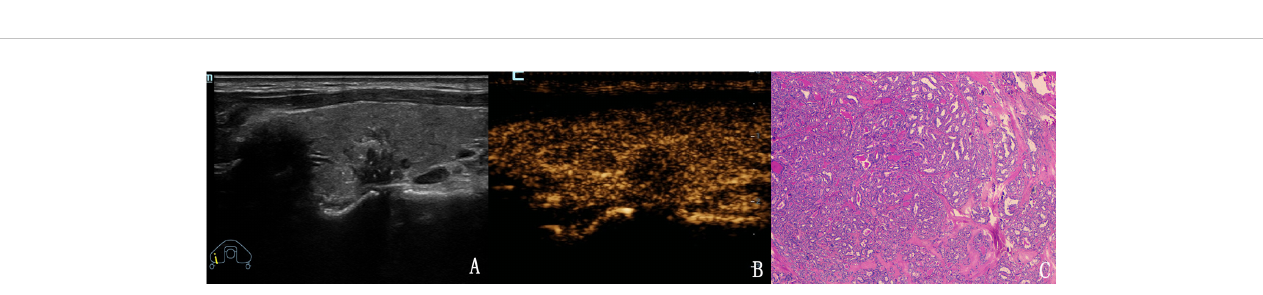
FIGURE 5 The case of a 43-year-old woman with a 15.2 × 11.1 × 12.5 mm solid hypo-echoic nodule in the right lobe of the thyroid. (A) Conventional two- dimensional image showing that the nodule had three malignant indicators (solid, irregular margin and microcalci fi cations) and was classi fi ed with a TI- RADS score of 4b. (B) Ultrasound contrast image showing low enhancement. The modi fi ed version of TI-RADS combined with CEUS returned a score of 5, and the patient was diagnosed with a malignant nodule. (C) Pathological image of the lesion, a PTC.